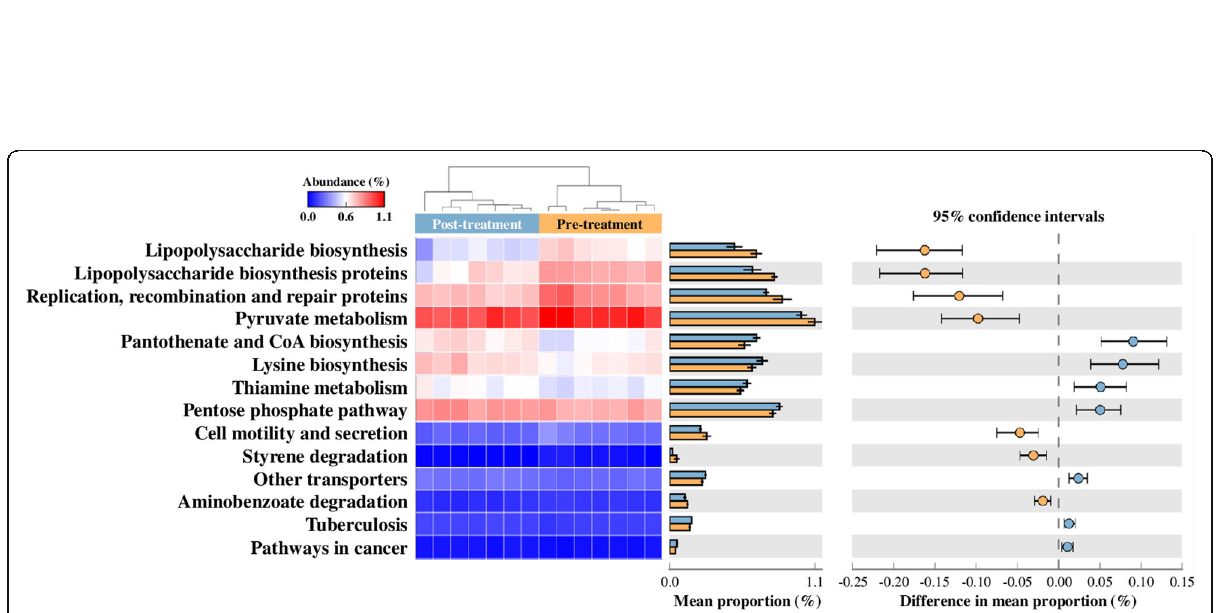
Fig. 5 Shift in metabolic function of uterine microbiota. Heat map and extended error bar plot show the 14 gene families with statistical significance between pre- and post-treatment in CEF (White ’ s non-parametric t-test, two-sided, P <